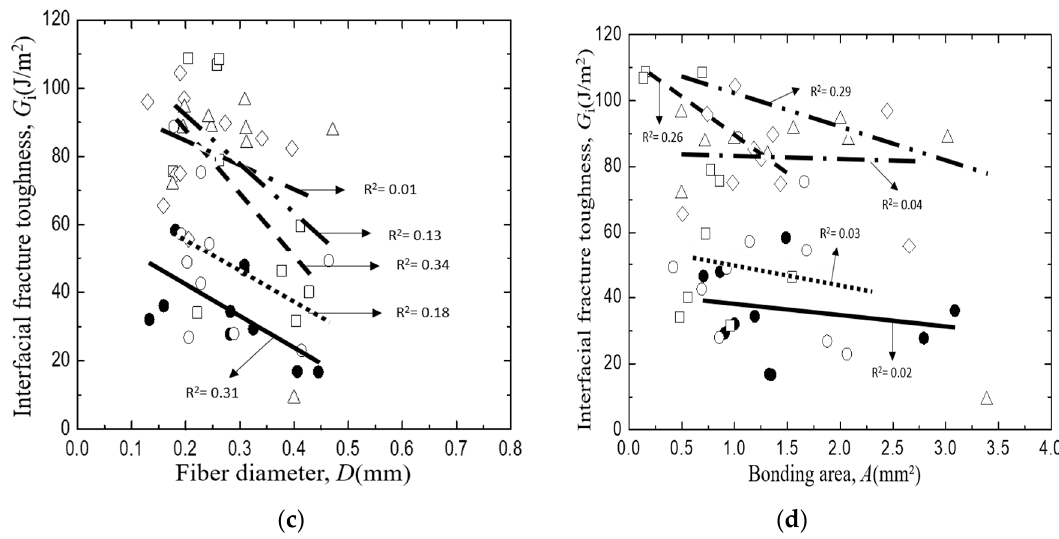
Figure 8. Interfacial fracture toughness of Typha spp. /Epoxy, where: ( a ) Matrix length, ( b ) Fiber spacing, ( c ) Fiber Diameter, ( d ) Bonding area.